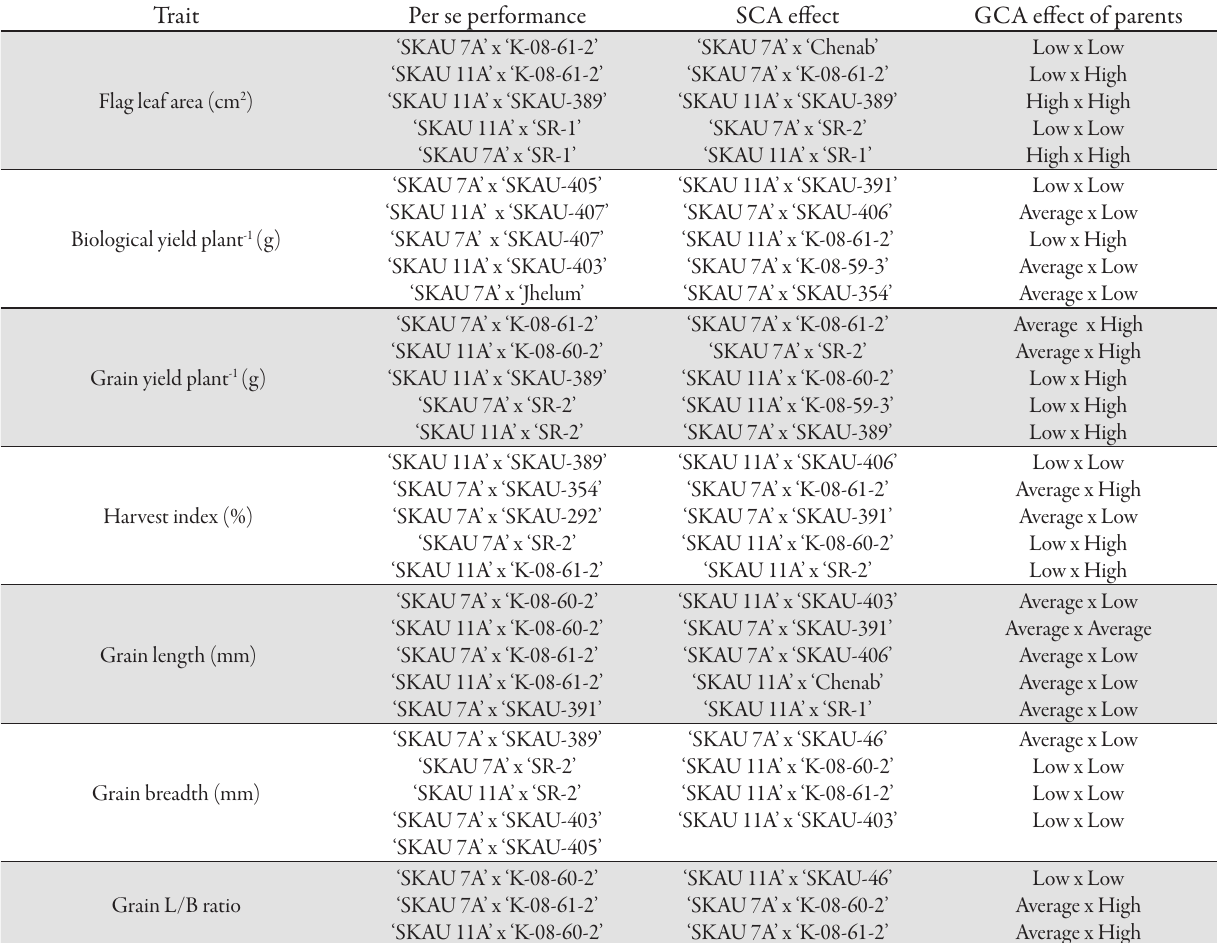
Tab. 7. Top ranking of specific cross combinations for different traits on the basis of SCA, per se , and GCA of parents involved in rice